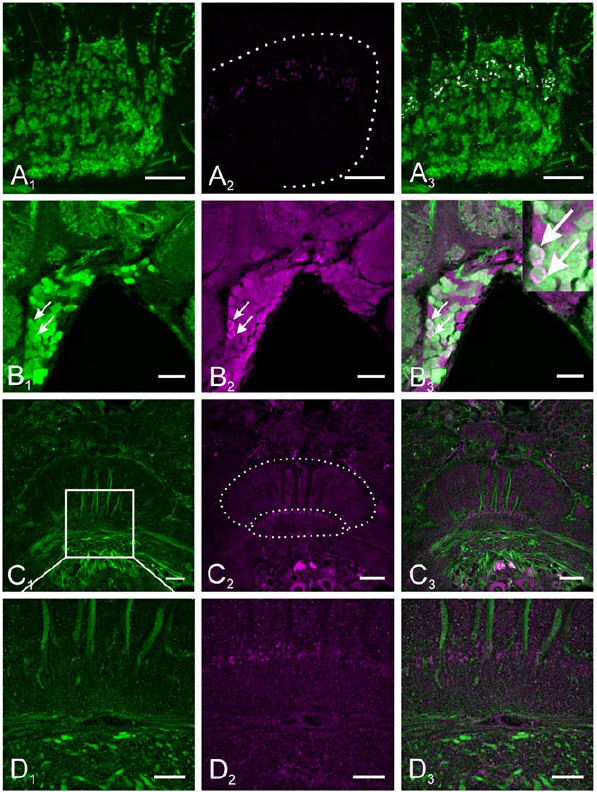
Figure 6. GABA, mAChR and NO-stimulated cGMP immunore- activity in the central complex. A 1 –B 3 Double labeling of GABA (green) and cGMP (magenta) in frontal sections through the midbrain. Colocalization (highlighted in white) was detected in tangential neurons of the central body lower division. All cGMP-immunoreactive neurites also contain GABA immunoreactivity, whereas only a subset of GABA-immunoreactive neurites accumulated detectable amounts of cGMP upon nitric oxide stimulation. Colocalisation of GABA and cGMP immunoreactivity was detected in five cell bodies per hemisphere in the infero-median protocerebrum (two of them are marked by arrows in B 1 –B 3 ). C 1 –D 3 Double labeling of mAChR (green) and cGMP (magenta) on frontal sections through the central complex. No colocalisation was detected, indicating that NO has no direct effect on mAChR-expressing columnar neurons of the central complex. Scale bars=50 m m in B 1 –C 3 ; 20 m m D 1 –D 3 ; 10 m m in A 1 –A 3 .